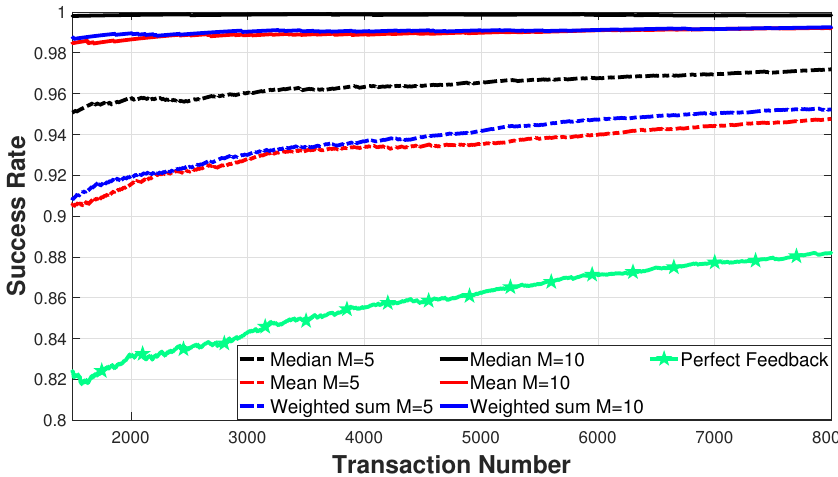
Figure 3. Transaction success rate for all